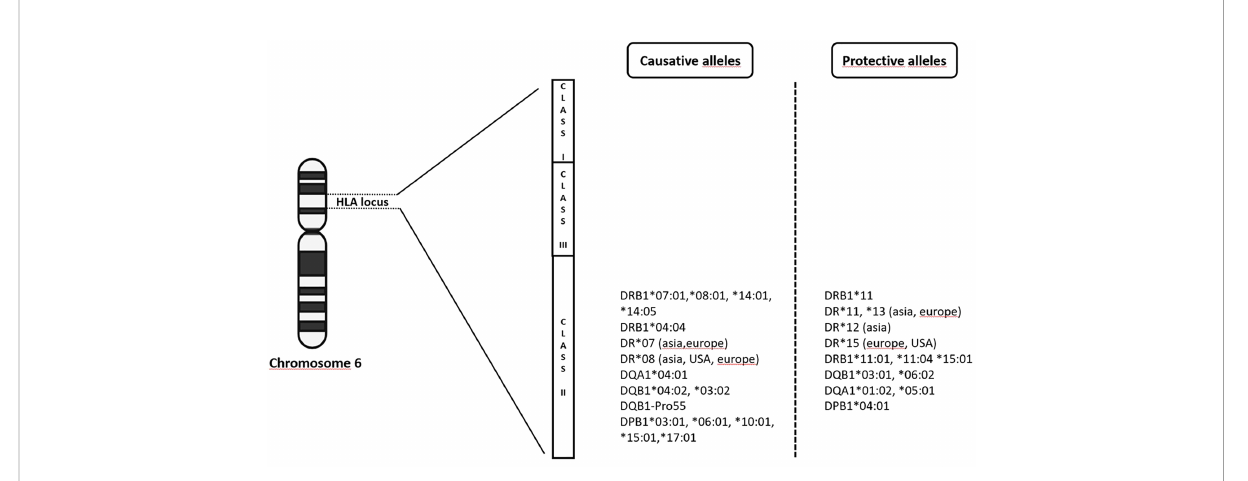
FIGURE 1 The complex milieux of HLA alleles and its association with PBC (increased vs protective